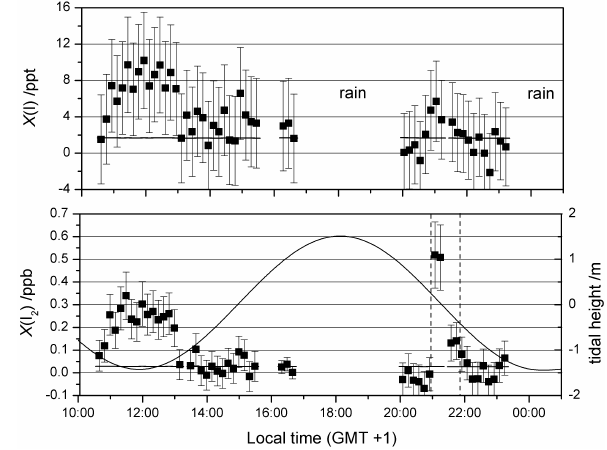
Fig. 10. Evolution of the background signal S b (I 2 ) (black squares) throughout the campaign, compared to the background signals dur- ing lab calibrations before (empty circle) and after (triangle) the campaign. The error bars indicate 1 standard deviation of the sig- nal. The insert shows spectra of a fresh (thick line) and an old lamp in the characteristic silicon spectral region.